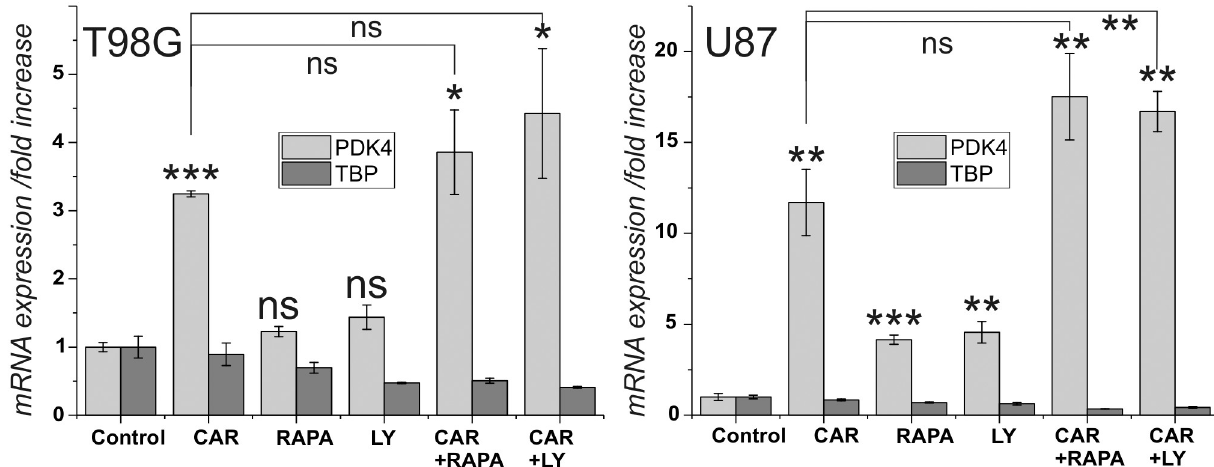
Fig 1. Influence of carnosine, rapamycin and Ly-294,002 on the expression of PDK4 and TBP in cells from the glioblastoma cell lines U87 and T98G. Cells from the lines U87 and T98G were cultivated for 24 hours in the presence of carnosine (Car; 50 mM), rapamycin (Rapa; 25 nM), Ly-294,002 (Ly; 5 μ M) or a combination of the compounds. Afterwards expression of PDK4 and TBP was measured and the fold change of expression under the influence of the compounds was determined. Asterisks above the columns indicate a significantly increased expression under the influence of the test compound compared to untreated control cells and the asterisks at the lines connecting columns indicate significant differences between the connected columns: ns: not significant; � : p < 0.05; �� : p < 0.005; ��� : p < 0.0005.